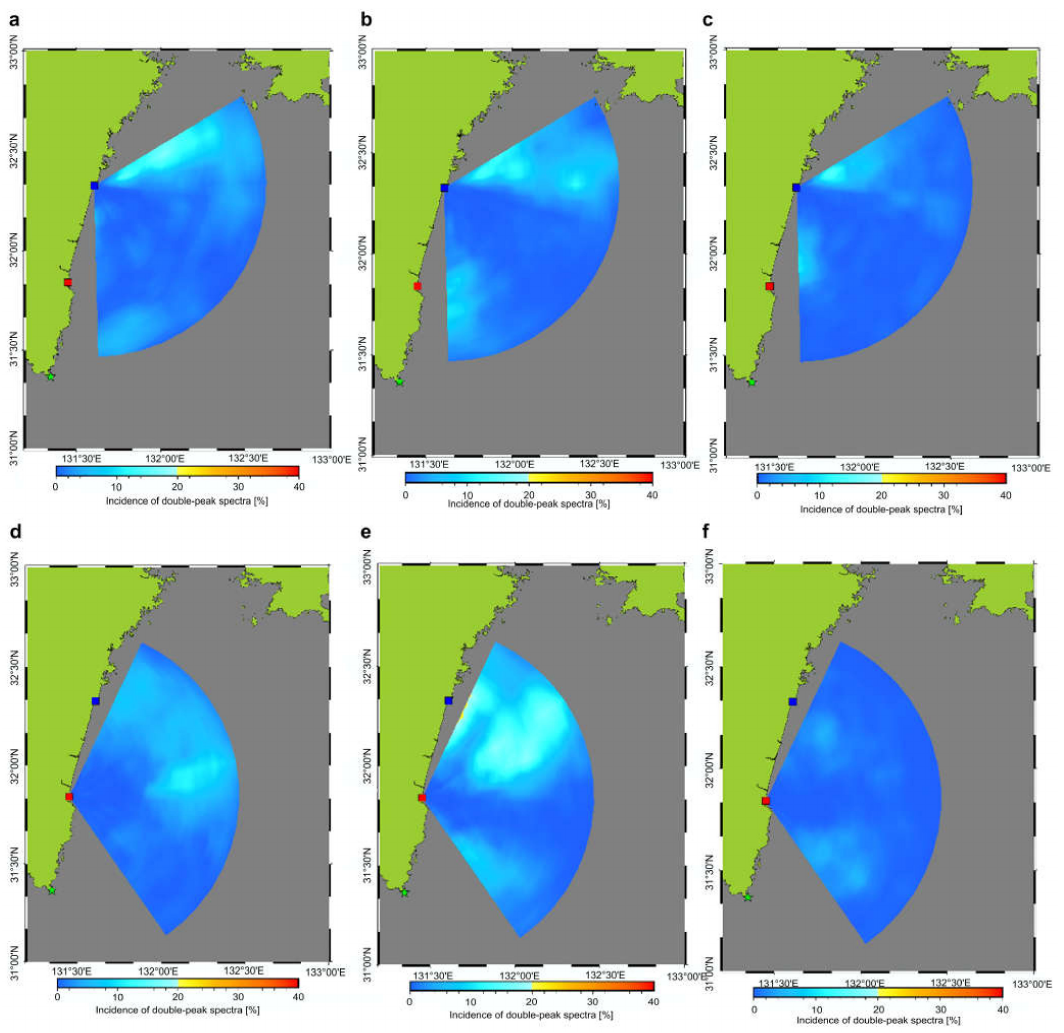
Figure 9. Changes in the spatial distribution of double-peak spectra from January to March 2021 (period 2 (cid:13) ). Mimitsu Station in ( a ) January 2021, ( b ) February 2021, and ( c ) March 2021. Miyazaki Station in ( d ) January 2021, ( e ) February 2021, and ( f ) March 2021.